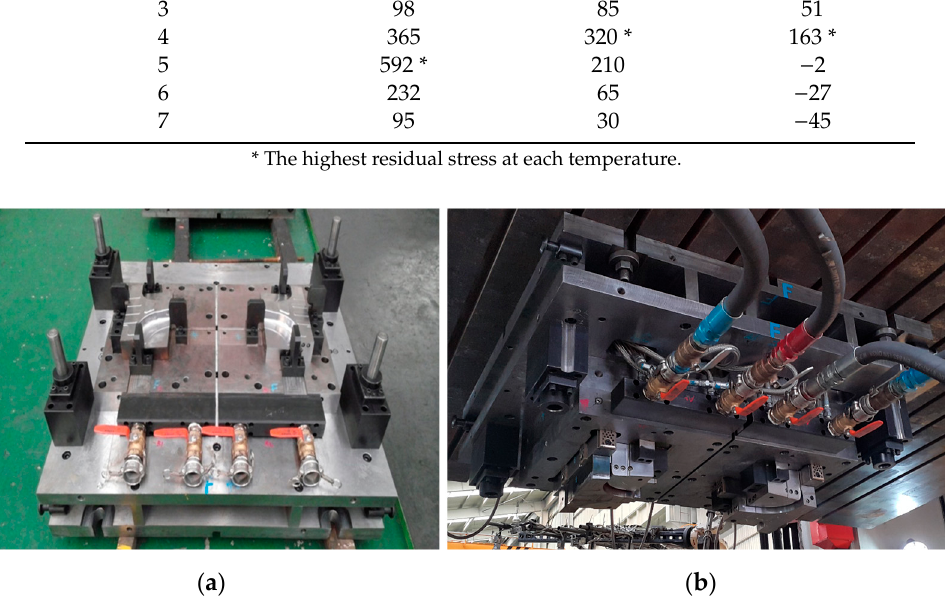
( b ) upper pad cooling block combined with the die body.